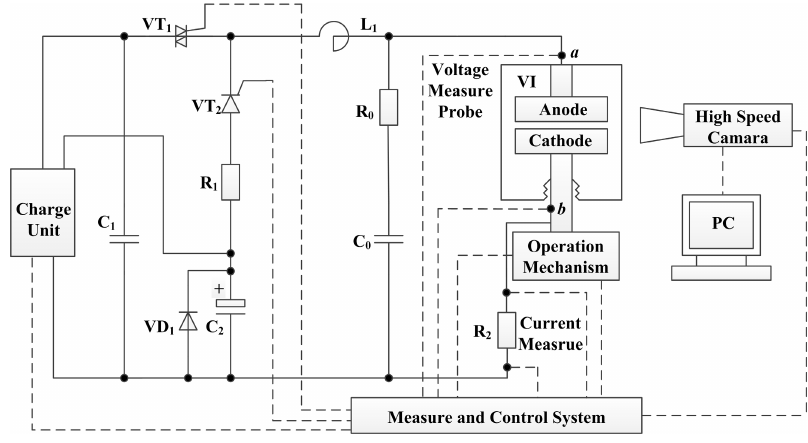
Figure 1. Schematic diagram of the experimental system.